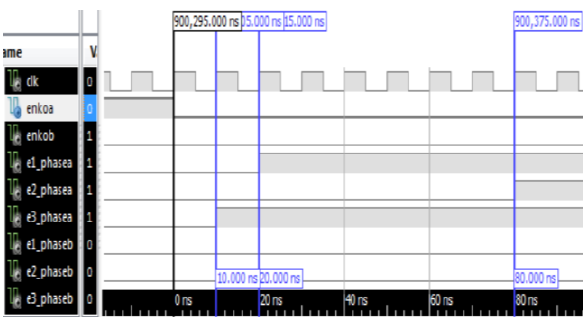
Fig. 1. Simulation results for rotor position detection modules.